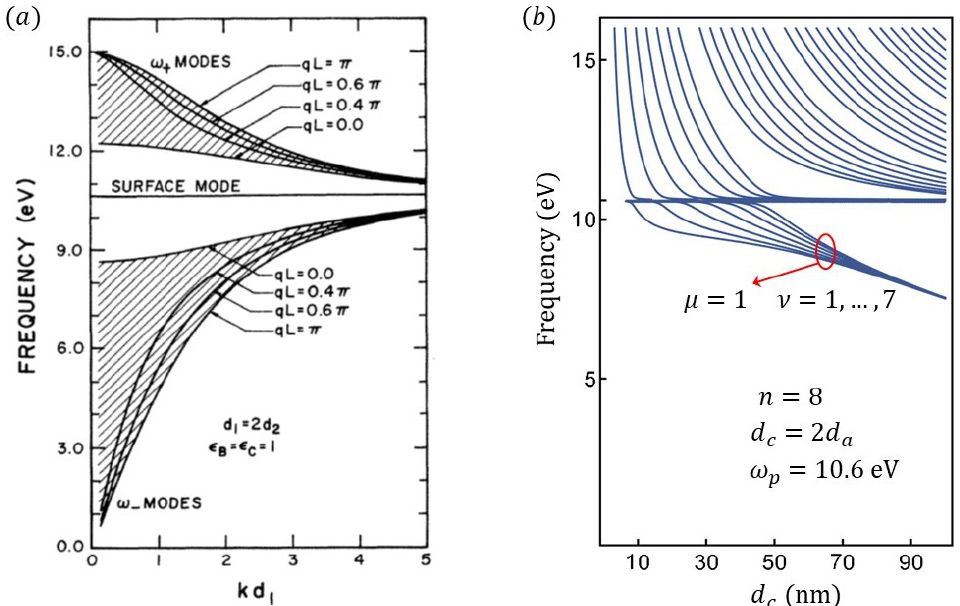
Figure 8. Subbands predicted for aluminum / dielectric superlattices in the semi-infinite and infi- nite superlattice approaches. In subfigure ( a ), the dispersion relations reported by Camley and Mills [8], for different values of the Bloch parameter qL ( K Λ ). In subfigure ( b ), the subbands for the dielectric / ( aluminum / dielectric ) n superlattice for the same parameters of the structure in ( a ), see text. The graph in subfigure ( a ), wa published in Phys. Rev. B 29 , 1695